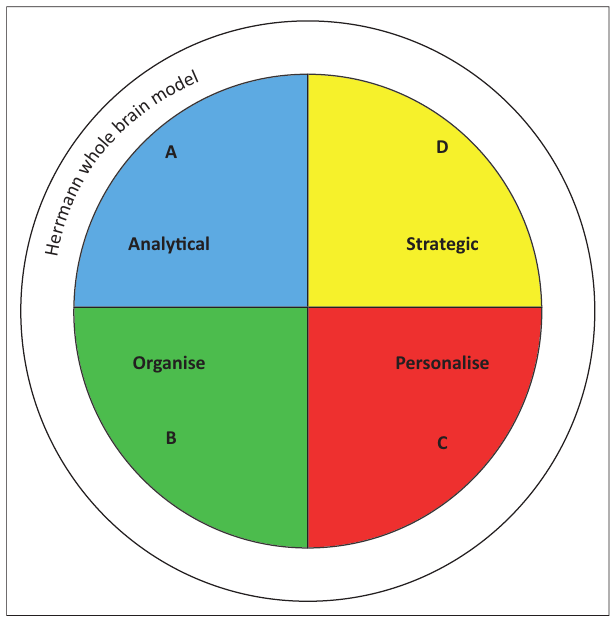
FIG URE 3: Core of the future-focused whole-brain